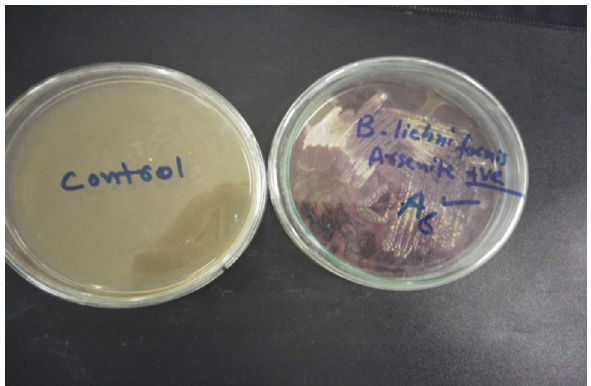
Fig. 2 Brown precipitates (right plate) showing the arsenite oxidizing ability of B. licheniformis A6. Left plate represents control (with out